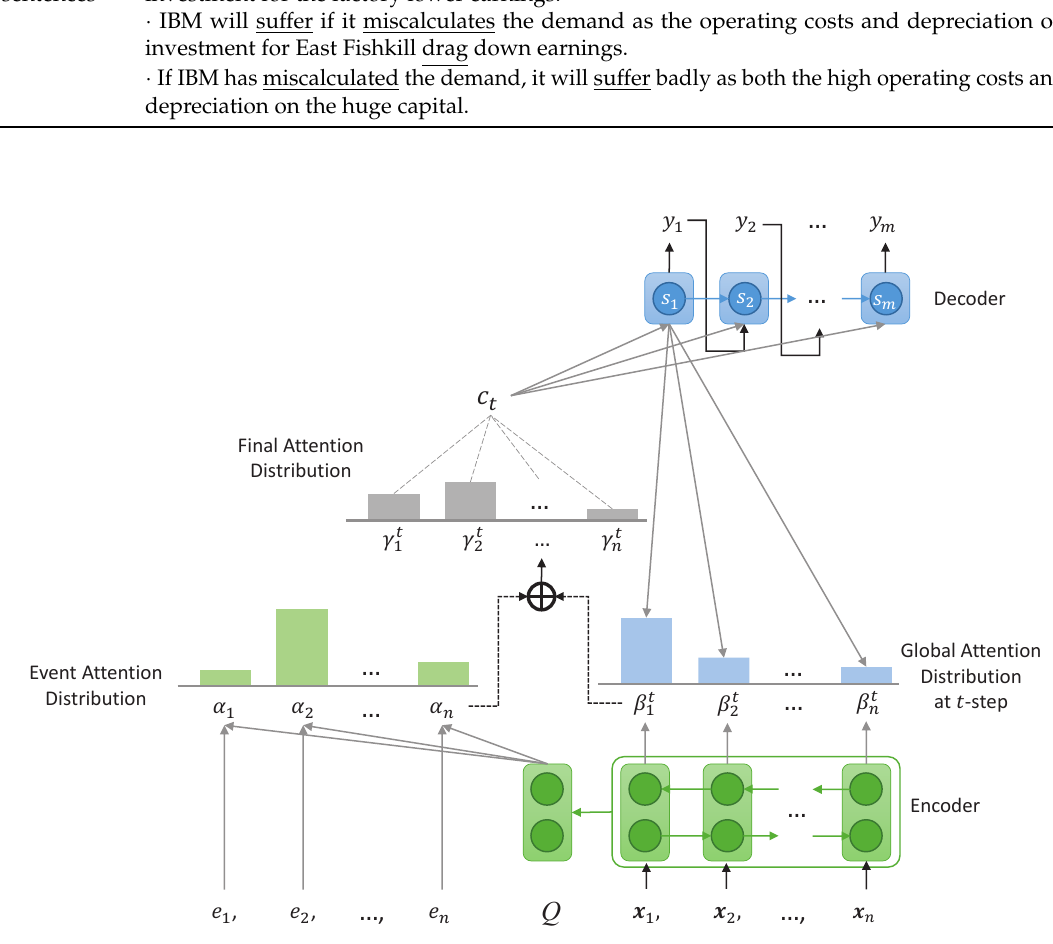
Figure 1. The overall process of abstractive sentence compression with event